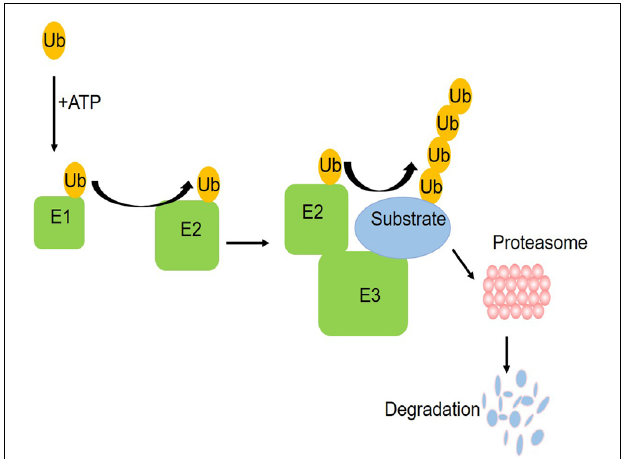
FIGURE 1 | A schematic figure of the ubiquitin proteasome system. Initially, a single free ubiquitin was activated by E1 in an ATP-dependent manner and then the activated monoubiquitin molecule is transferred to a cysteine residue of the E2 enzyme, which is subsequently recruited into the E3 ligases. Working with a specific E3, E2 transferred one or more ubiquitin moieties sequentially to form ubiquitin chains to the substrate protein. Finally, the proteasome system can target the ubiquitinated substrate protein for